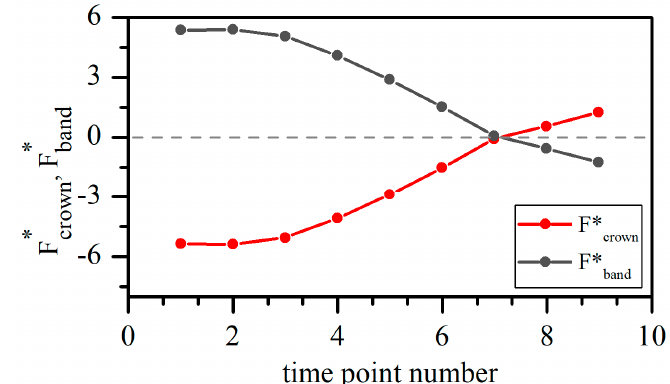
Figure 15. Axial forces of